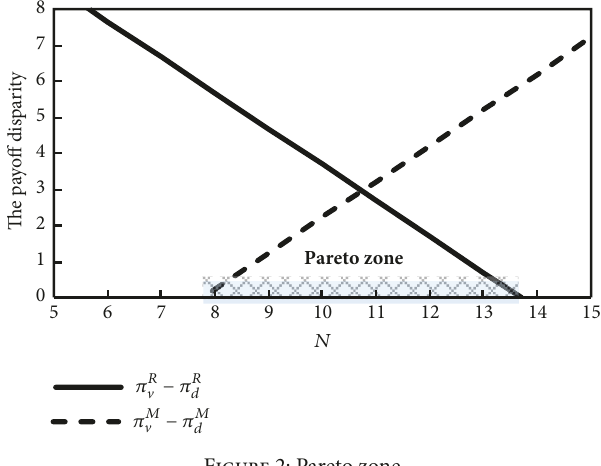
Figure 2: Pareto